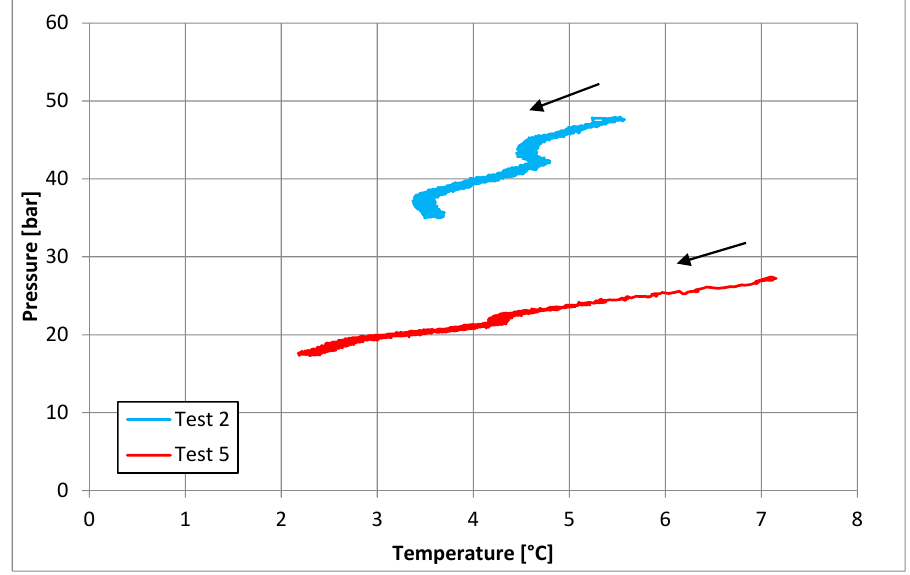
Figure 5. Comparison between Test 2, carried out using CH 4 , and Test 5, performed with CO 2 .